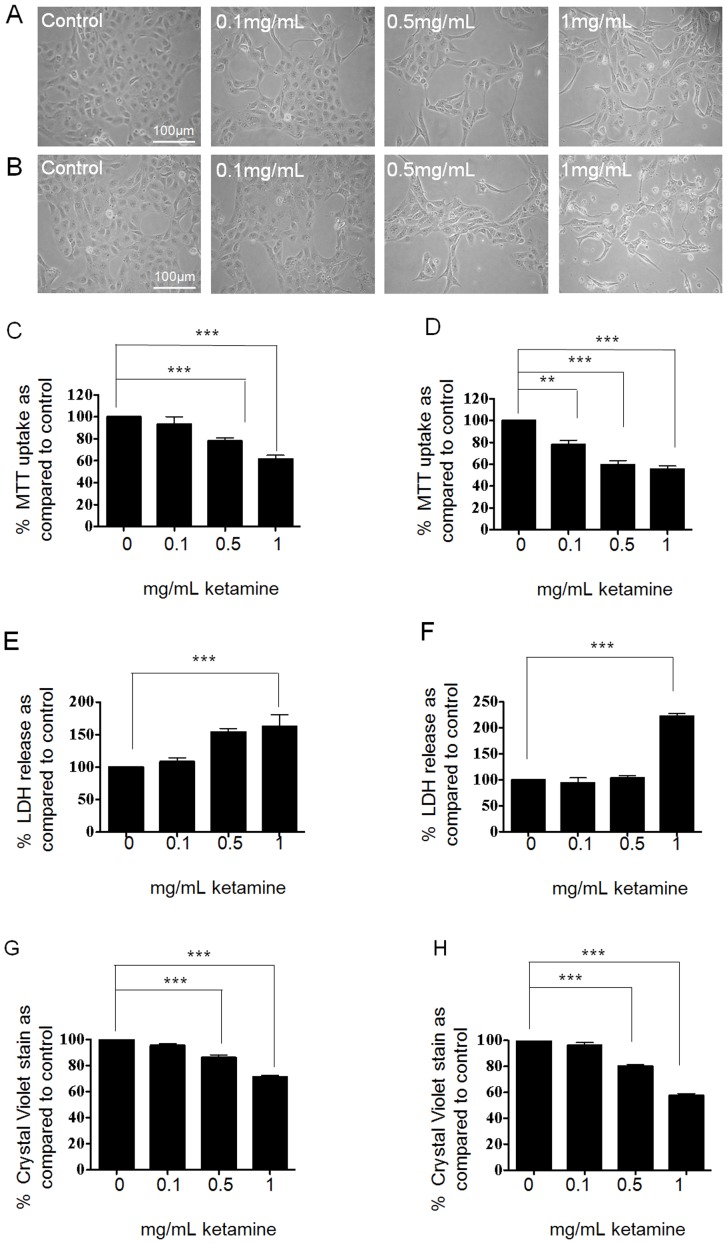
Impact of Ketamine on HK2 cell viability, as assessed by phase contrast microscopy, MTT uptake, Crystal Violet staining and LDH release.HK2 cells were cultured in 5 mM glucose containing media for 48 hrs prior to an overnight serum starvation. Cells were stimulated for 24–48 hrs with Ketamine (0.1–1 mg/mL) under serum-free conditions and morphological changes assessed (Panels A and B respectively). Ketamine evoked a concentration dependent change in cell morphology from a typical proximal tubular epithelial “cobblestone” appearance to an elongated fibroblast appearance. Cell viability was assessed by MTT uptake at 24 and 48 hrs (panels C and D respectively). Incubation with Ketamine at 0.5 and 1 mg/mL caused a significant decrease in viable cells as measured by MTT uptake. Cell membrane damage was assessed via LDH release at 24 and 48 hrs (panels E and F respectively). At both 24 and 48 hrs, Ketamine (1 mg/mL) caused a significant increase in LDH release. Finally cell density was determined by the Crystal violet assay. Ketamine evoked a reduction in cell density at 24 and 48 hrs (panels G and H respectively). The values obtained are expressed as a % of control (C). Results are representative of 3 separate experiments. Key significances are shown where **P<0.01 and ***P<0.001.